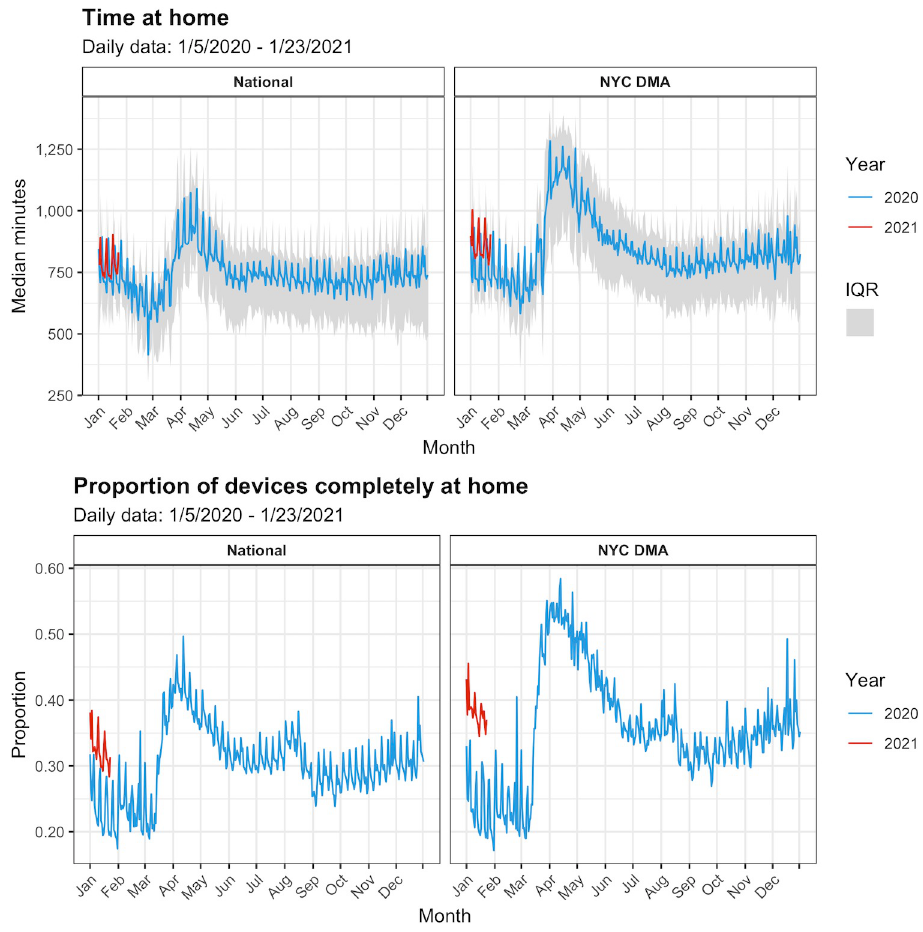
Fig 1. Mobility indicators over time nationally and in the NYC DMA: 2020–2021. Note: Mobility data was aggregated to the weekly-level for time-series analyses.